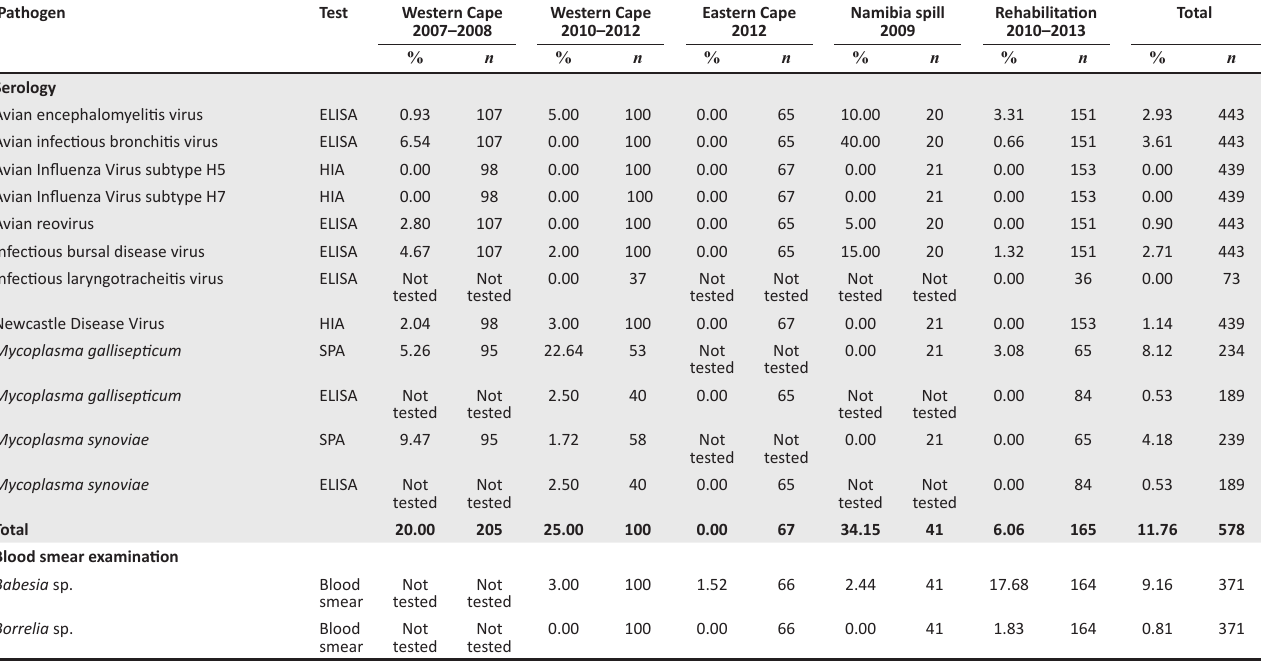
TABLE 2: Diagnostic results for pathogens tested during this health assessment of African penguins.